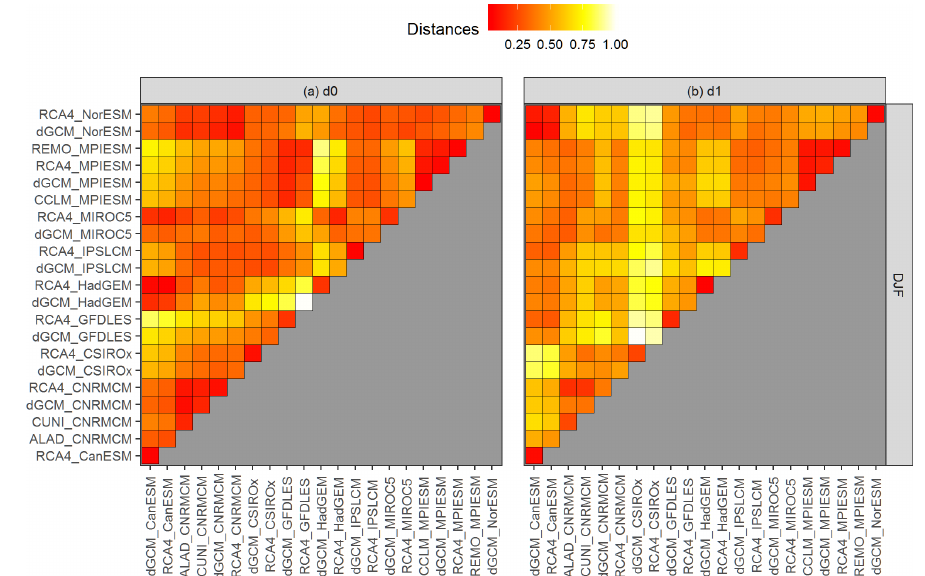
Figure 6. (a) Heat map of the d 0 distances for running 30-year mean changes in winter (DJF) mean air temperature over British Isles (the curves are shown in Fig. 1b, underlying data are shown in Fig. 1a) with redder color for more similarity and brighter color for less similarity between respective curves. The values of the semimetric d 0 are scaled to the interval [0,1]. The acronyms of the model simulations are explained in Sect. 2. The definition of the distances is explained in Sect. 3.1. (b) is the same as (a) , but for d 1 distances.